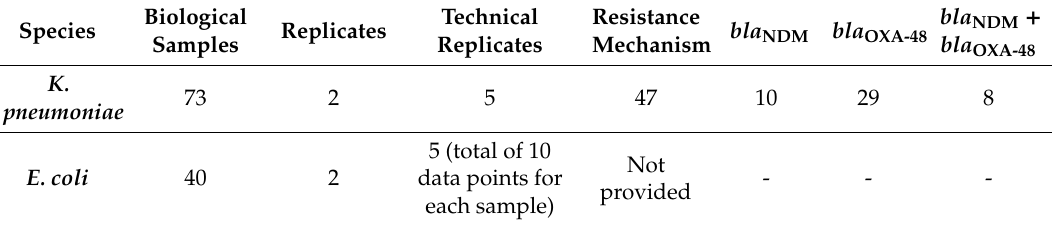
Table 1. Summary of K. pneumoniae and E.coli biological samples; replicate numbers and characterised molecular resistance